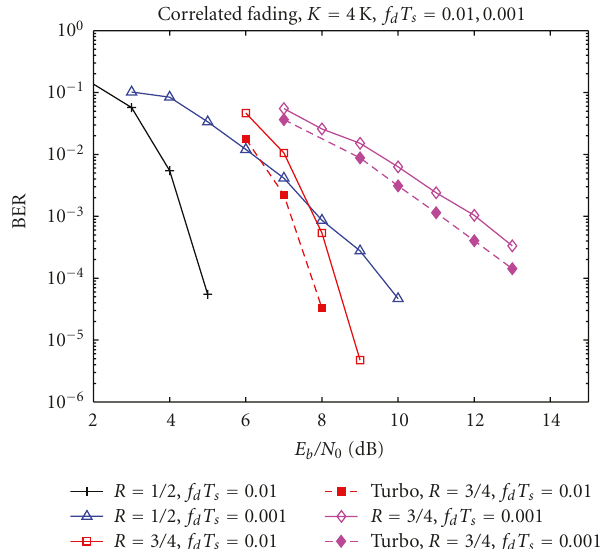
Figure 5: Performance of PA codes on correlated Rayleigh fading channels with CSI. Data block length 4K, normalized Doppler rate f d T s = 0 . 01, 0.001, rate of PA codes 0.5 and 0.75, rate of turbo codes 0.75, component codes of the turbo code (1,35 / 23) for PA codes, and 6 iterations for turbo